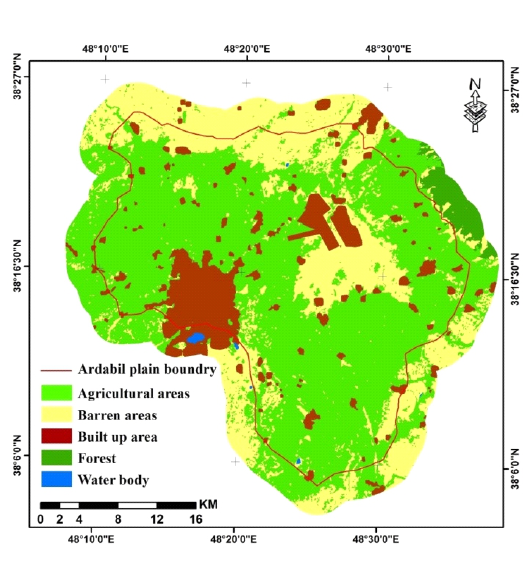
Fig 7: Predicted landuse map for